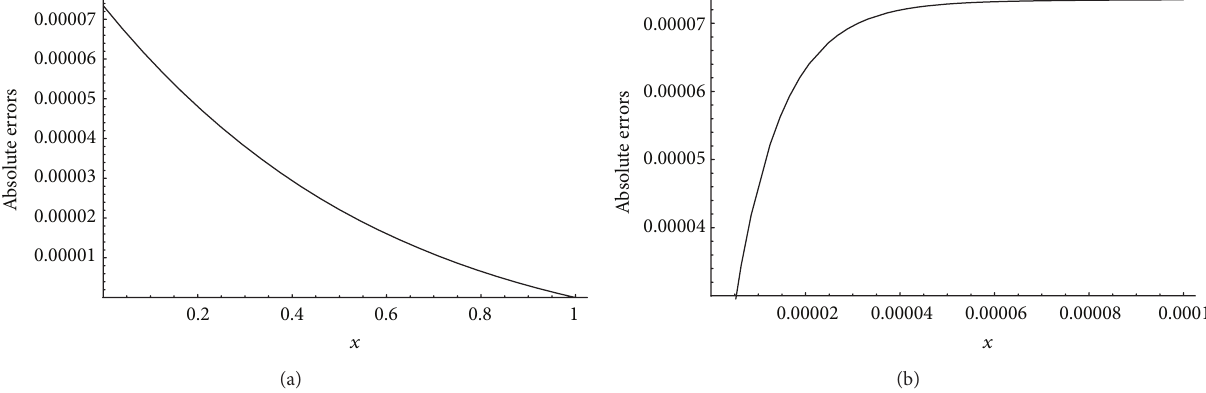
For detailed method of obtaining reproducing kernel 𝑅 𝑥 (𝑦) , please refer to [9,